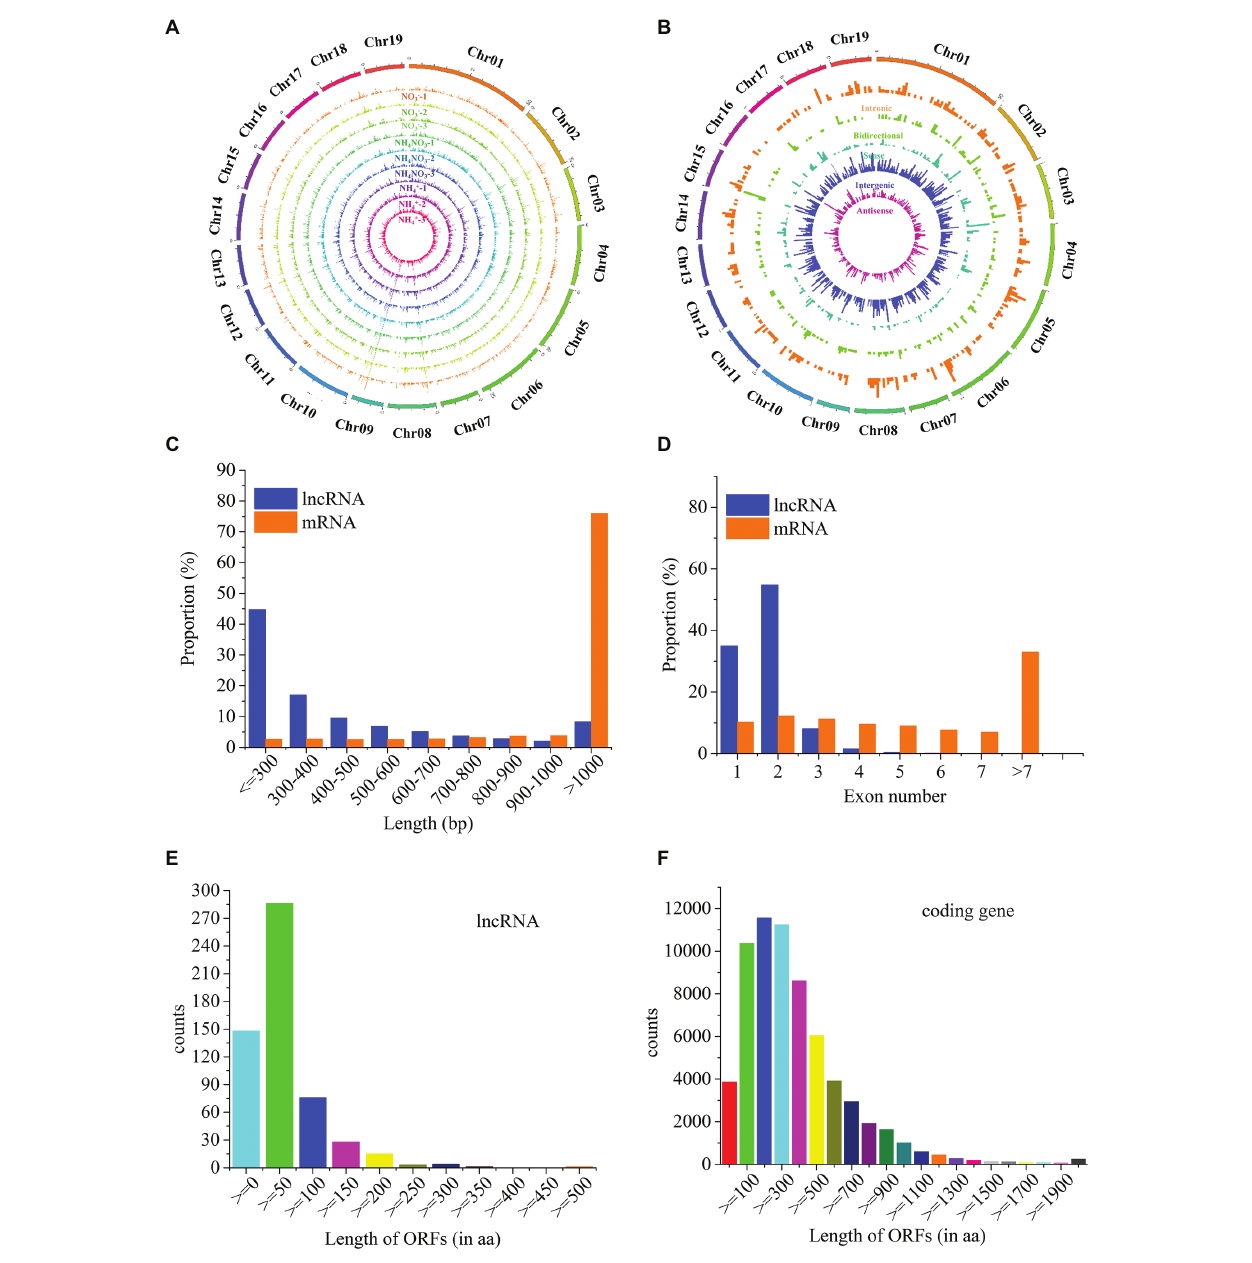
FIGURE 2 | Comparison of structural features of lncRNAs and mRNAs. (A) , The expression level of lncRNAs along the 19 chromosomes. (B) , Chromosomal distribution of the five types of lncRNAs. (C) , Comparison of transcript lengths of lncRNAs and mRNAs. Blue represents lncRNAs, red represents mRNAs. (D) , Comparison of exon numbers of lncRNAs and mRNAs. Blue represents lncRNAs, red represents mRNAs. (E) , Open reading frame (ORF) length of lncRNAs. (F) , ORF length of